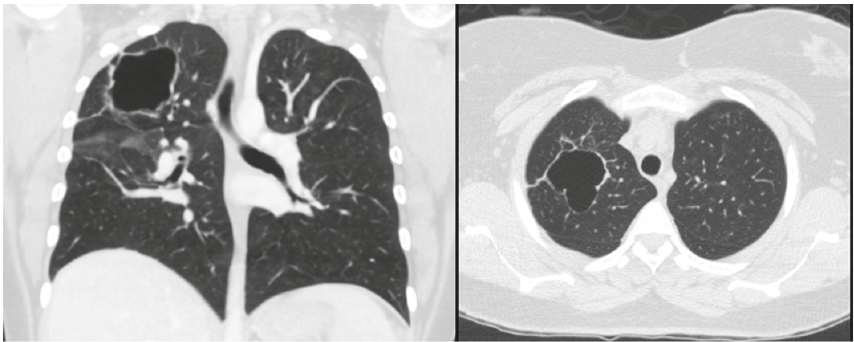
Figure 5: Chest CT on discharge showing resolution of the BPF and development of thin wall right upper lobe